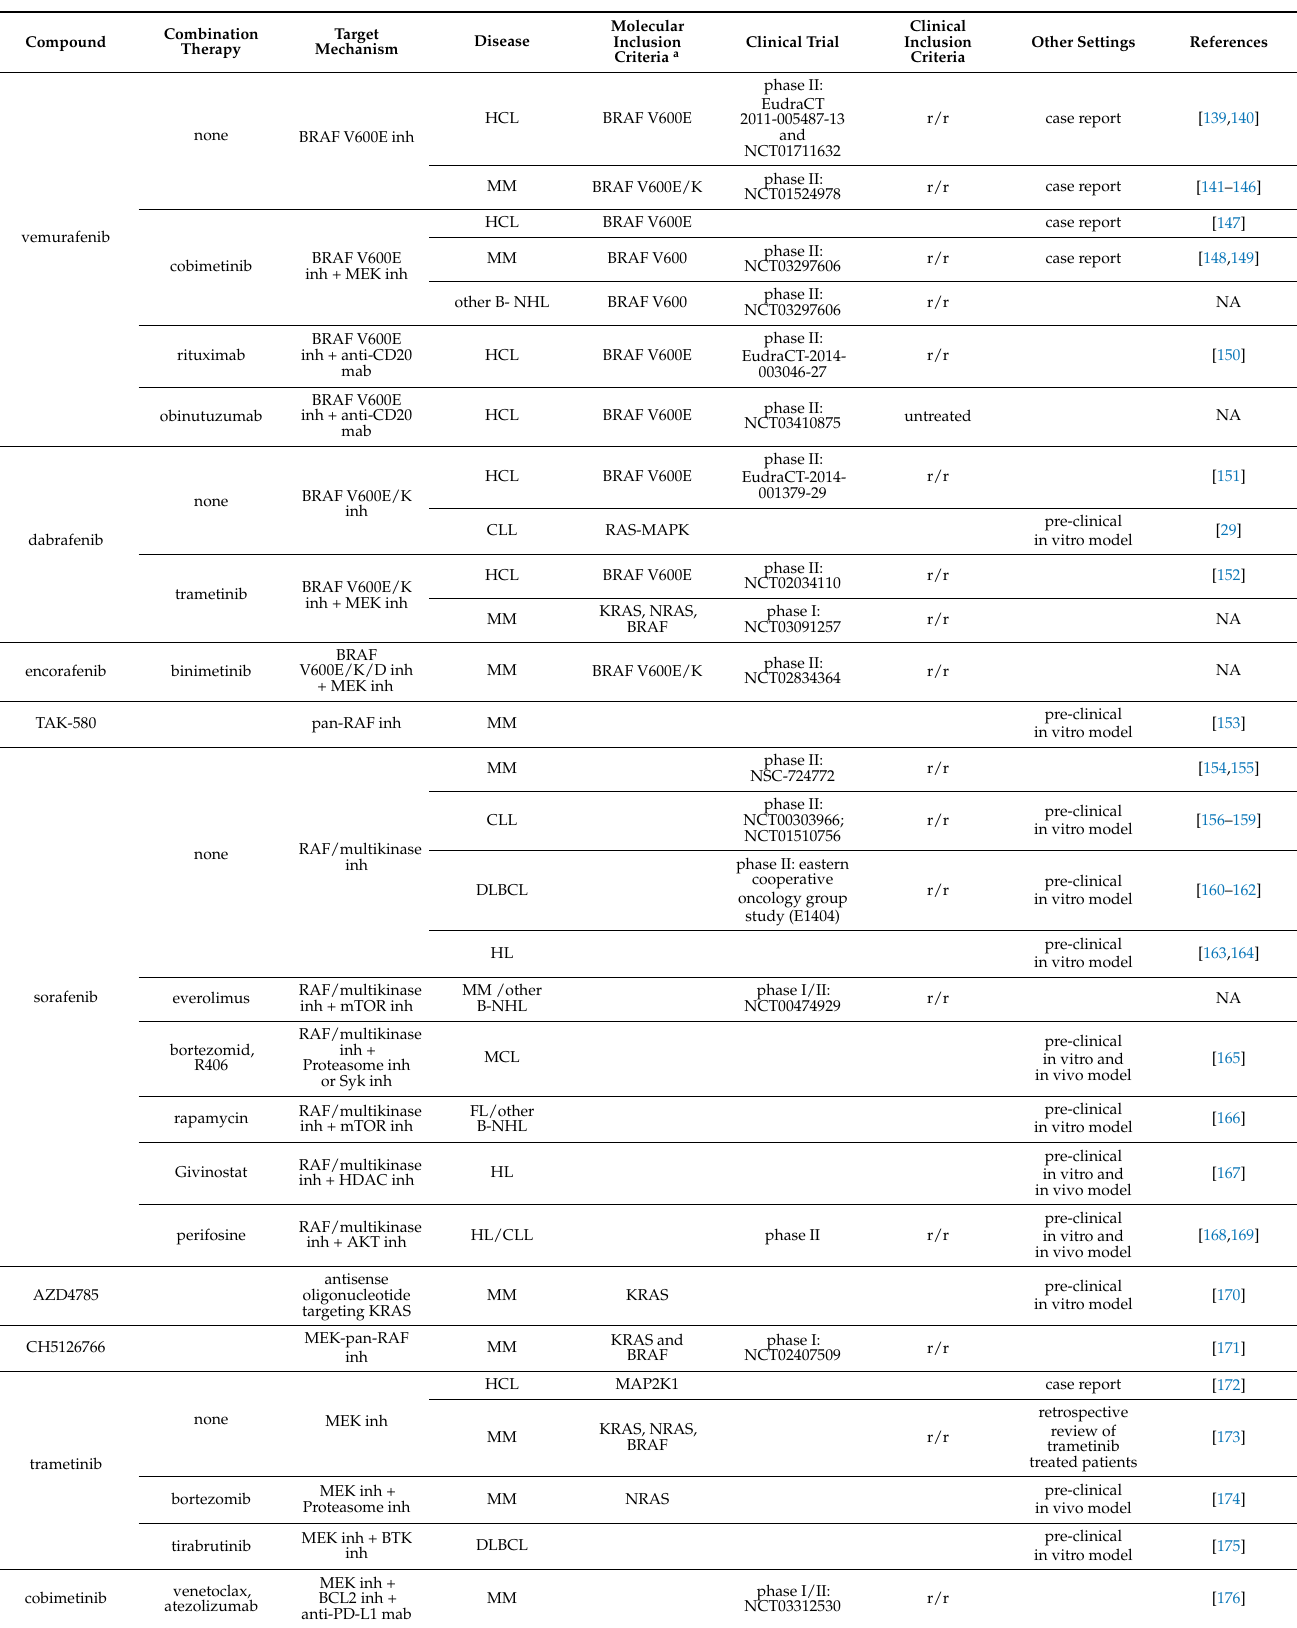
Table 2. RAS-MAPK pathway inhibitors in lymphoproliferative